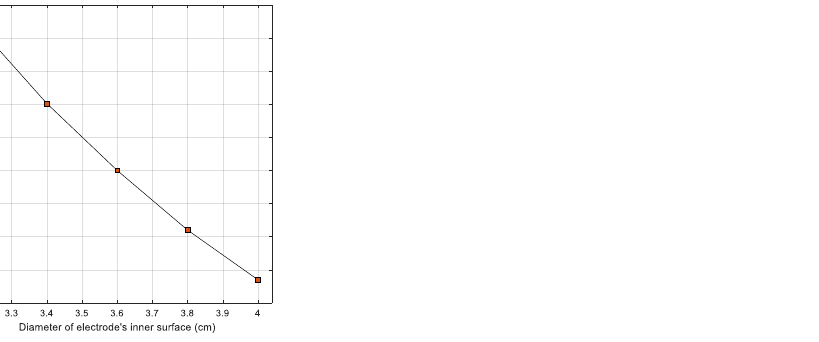
Figure 7. Diagram of relationship between sensor capacity and electrode inner diameter.